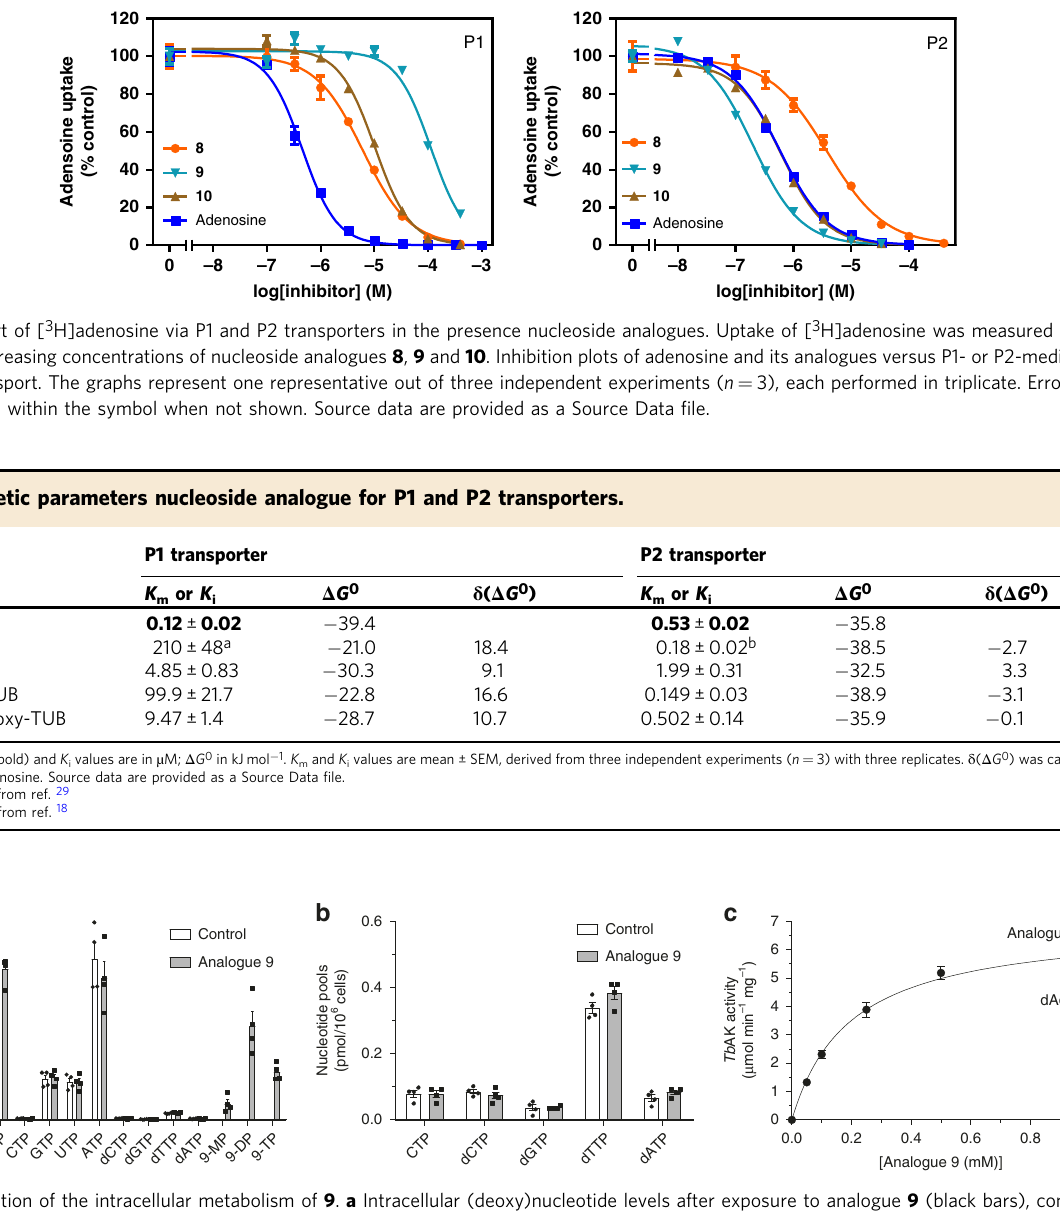
Fig. 6 Investigation of the intracellular metabolism of 9 . a Intracellular (deoxy)nucleotide levels after exposure to analogue 9 (black bars), compared to non-treated control cells (white bars). b Enlargement of less abundant nucleotides from a . c Determination of kinetic parameters of 9 incubated with puri fi ed recombinant Tb ADKIN enzyme. The graphs represent the average of 3 – 4 independent experiments with the error bars indicating SE ( n = 4 for a , b and n = 3 for c ). Source data are provided as a Source Data fi